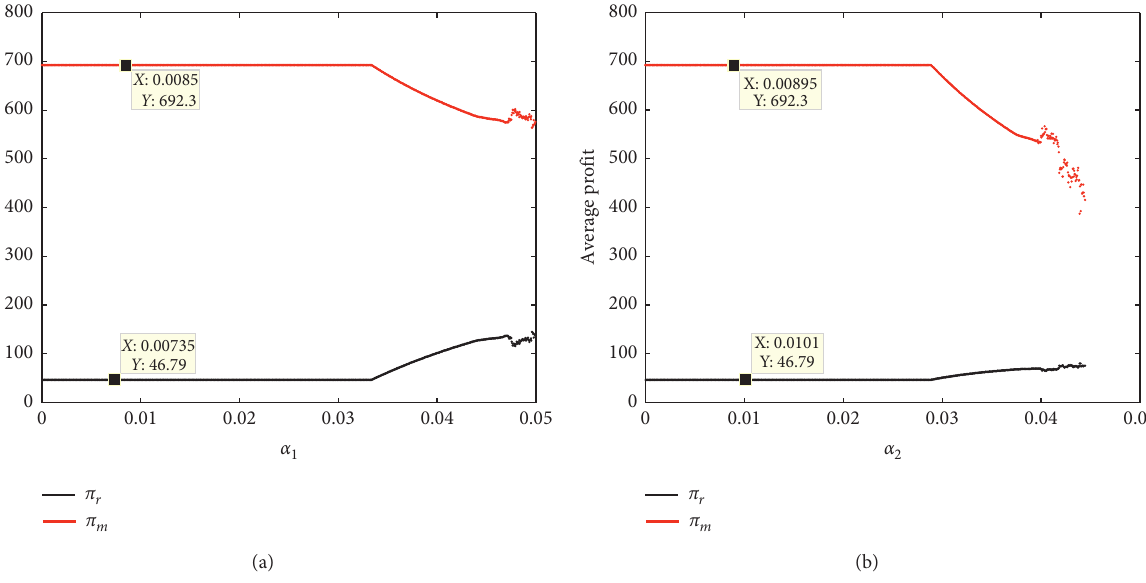
� 0 . 02 , α � 0 . 04. 1 2